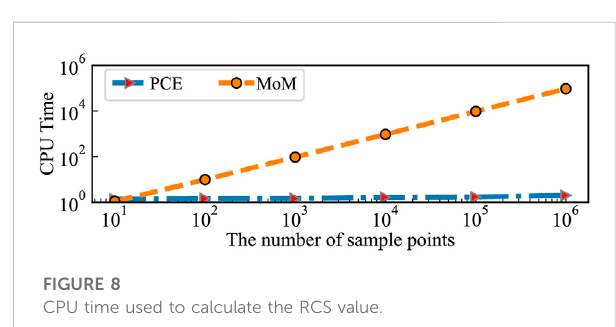
FIGURE 8 CPU time used to calculate the RCS